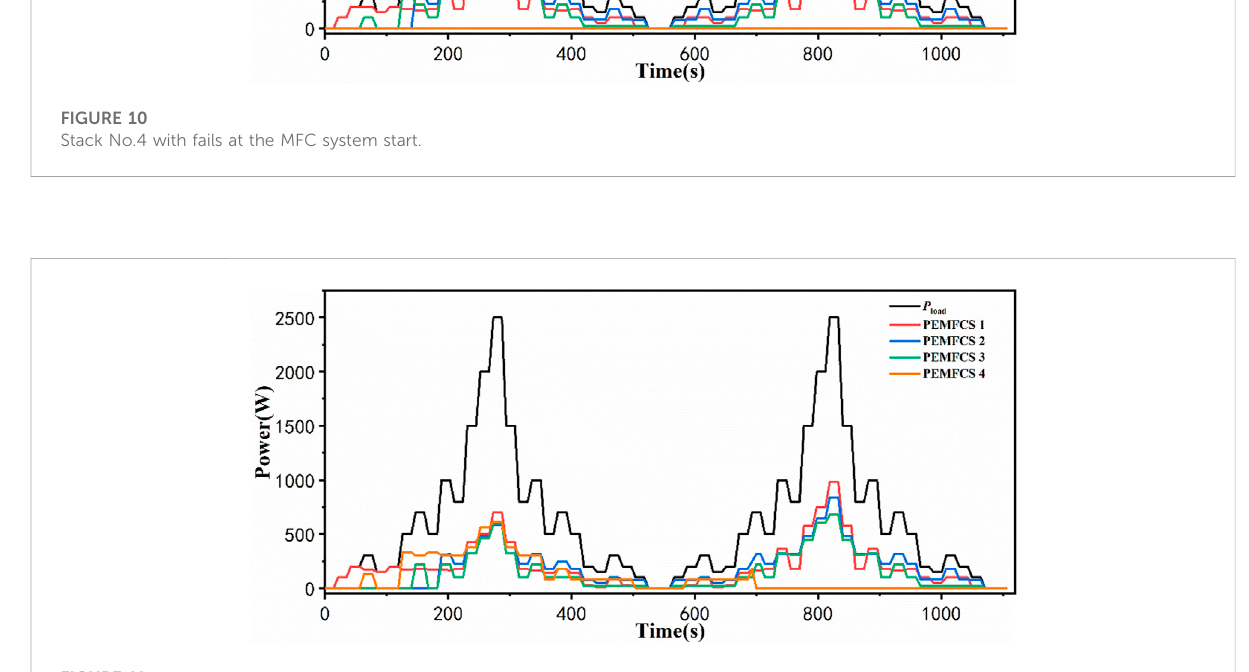
FIGURE 11 Stack No.4 with fails at the 200th